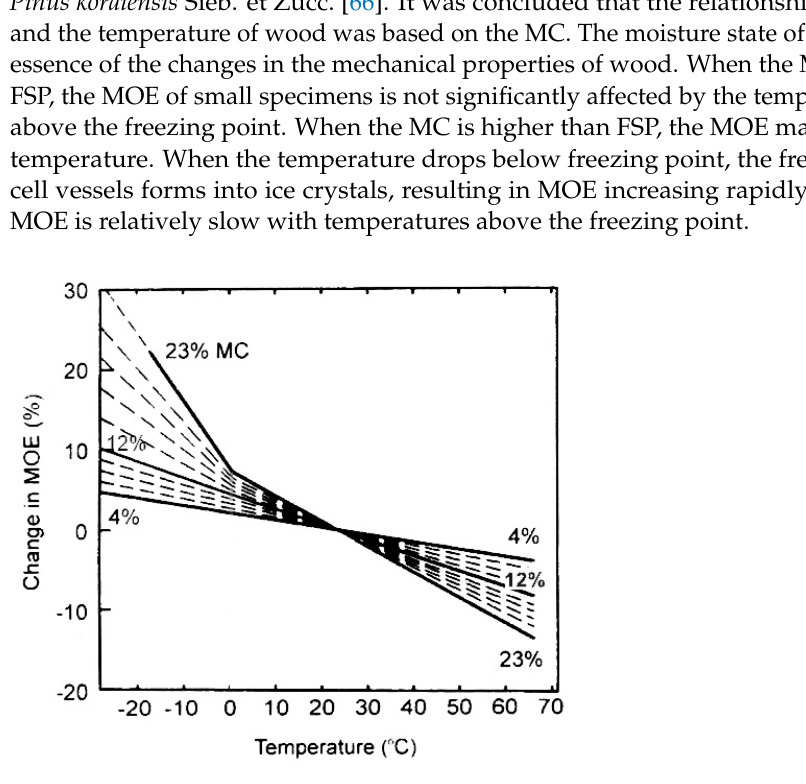
Figure 3. Predicted-relationship between change in MOE and temperature at various MC levels. From Green et al. [65].